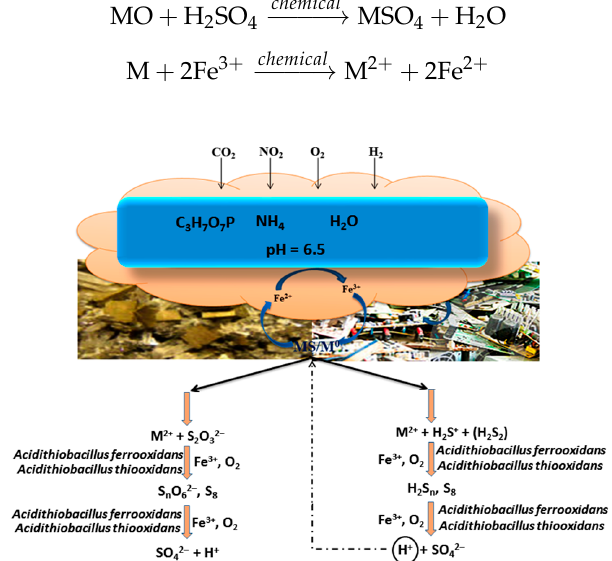
Figure 3. Interaction of Acidithiobacillus ferrooxidans with metals on surface of source material [23].